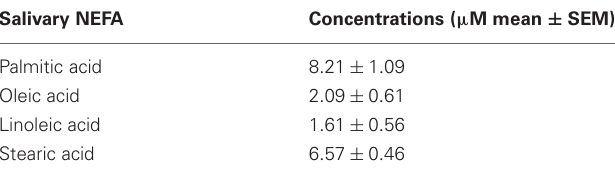
Table 2 | Major salivary NEFA (number of participants = 15). Salivary